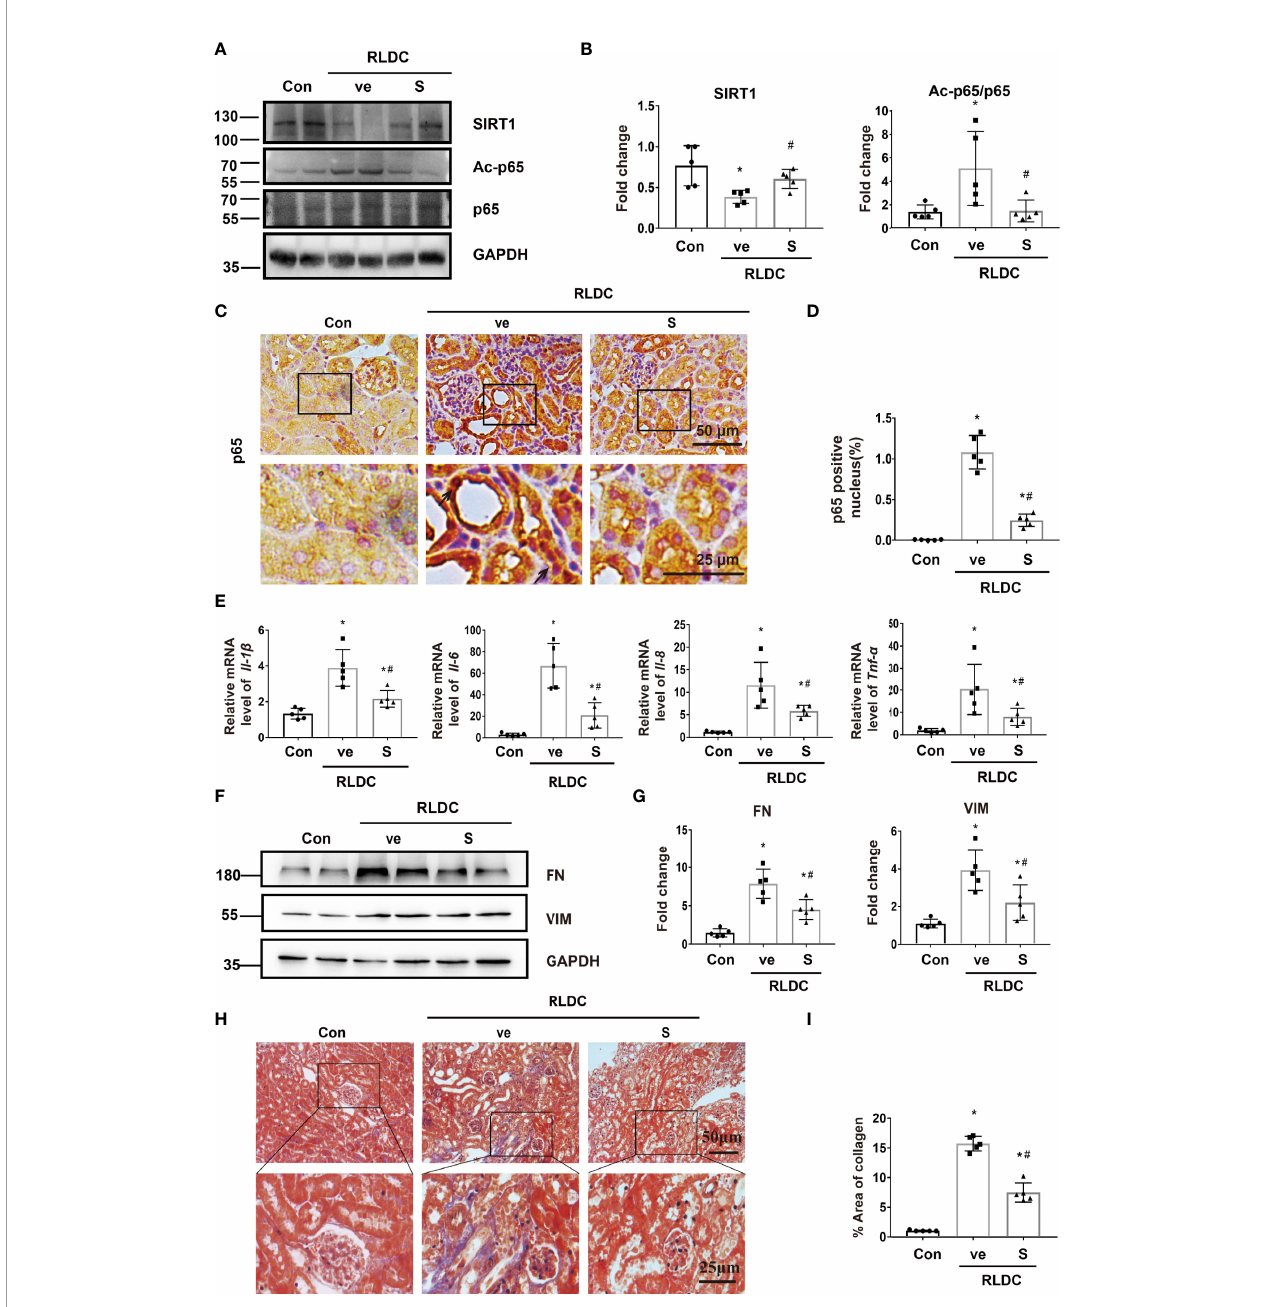
FIGURE 4 | SIRT1 activator reduces p65/NF- k B activation and ameliorates kidney in fl ammation and fi brosis after post-RLDC treatment. Male C57BL/6 mice were given 4 weekly injections of 8 mg/kg cisplatin. After the last cisplatin injection, SRT1720 (S) or vehicle solution (ve) was injected daily for 1 week or 1 month to collect samples for analysis. (A) Representative immunoblots of SIRT1, Ac-p65, p65 and GAPDH (loading control) of total protein extracted from mouse kidney (n=5). (B) Densitometry of SIRT1, Ac-p65, p65. The protein level of control group was arbitrarily set as 1. SRT1720 prevented SIRT1 decrease in post-RLDC mice and reduced p65 acetylation. (C) Representative images of immunohistochemical staining of p65 in post-RLDC mice. (n=5). (D) Percentage of p65 positive nuclei. (E) mRNA levels of Il-1 b , Il-6, Il-8, Tnf- a in mice quanti fi ed by qRT-PCR showing the inhibitory effect of SRT1720 (n=5). Data are normalized to Gapdh and expressed as fold change compared to controls. (F) Representative immunoblots of FN, VIM and GAPDH showing the inhibitory effect of SRT1720 on fi brotic protein expression (n=5). (G) Densitometry of FN and VIM. The protein level of control group was arbitrarily set as 1, and the signals of other conditions were normalized